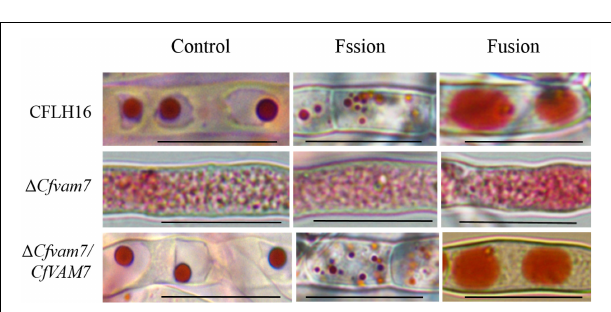
FIGURE 6 | CfVam7 regulates vacuole fusion. Vacuoles were labeled with neutral red and incubated for 15 min in potato dextrose broth (PDB) medium plus 0.5 M of NaCl for fission experiments. For fusion experiments, hyphae were further incubated for 2–4 h in water. Scale bar = 20 µ m.